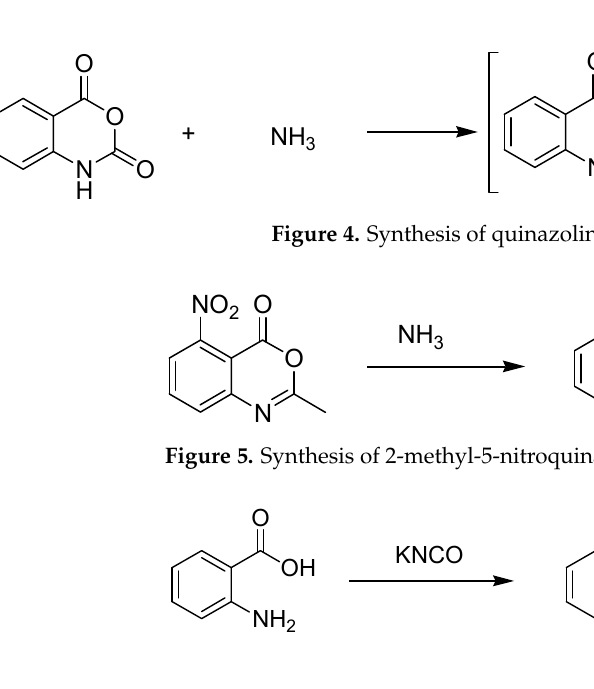
dihydro-4-oxaquinazolines (Figure 4) [1].